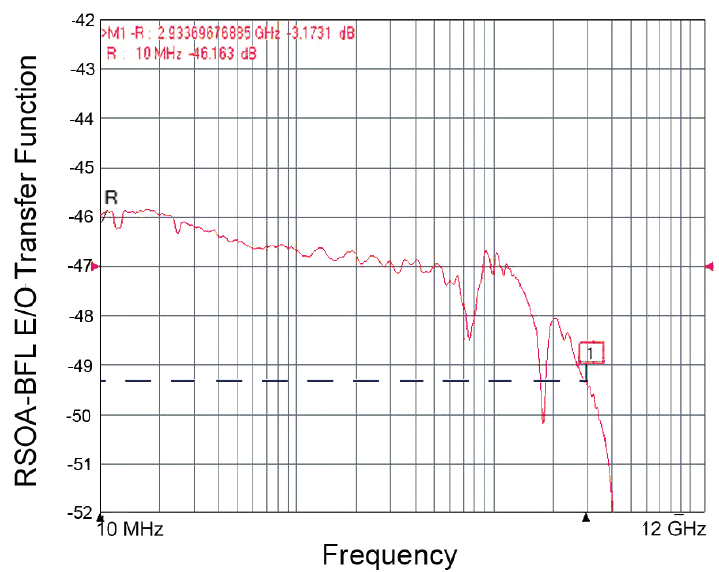
Figure 10. E/O response of RSOA-BFL combination. The dashed line indicates the 3-dB electrical modulation